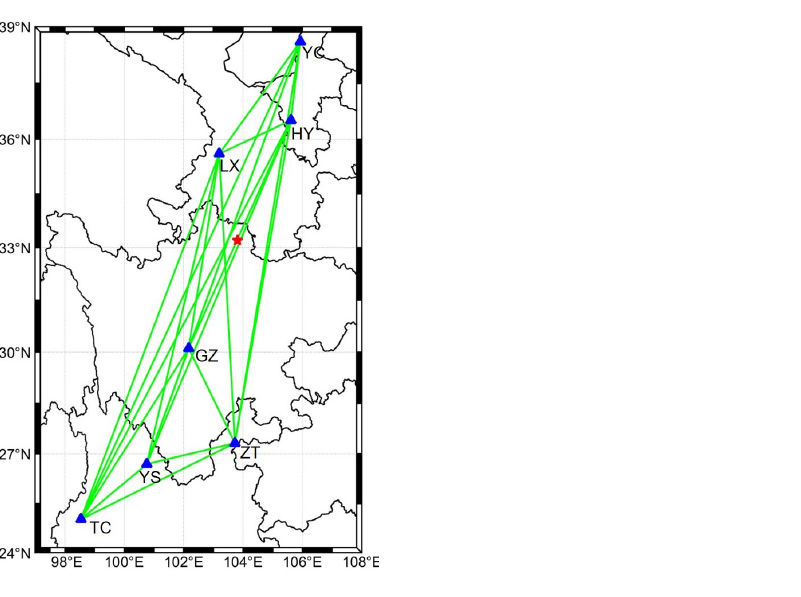
Figure 3. An example of the strain network result for a fully connected network on 8 August 2017, Ms7.0 Jiuzhaogou earthquake. The green lines represent the connections between two stations. The red star shows the epicenter of the earthquake.